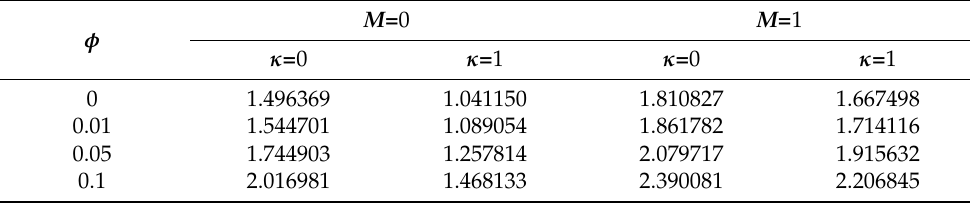
Table 5. Values of Table 5. Values of C f Re 1/2 x for magnetite ferrofluid with variations of M , κ , and φ when λ = − 2.